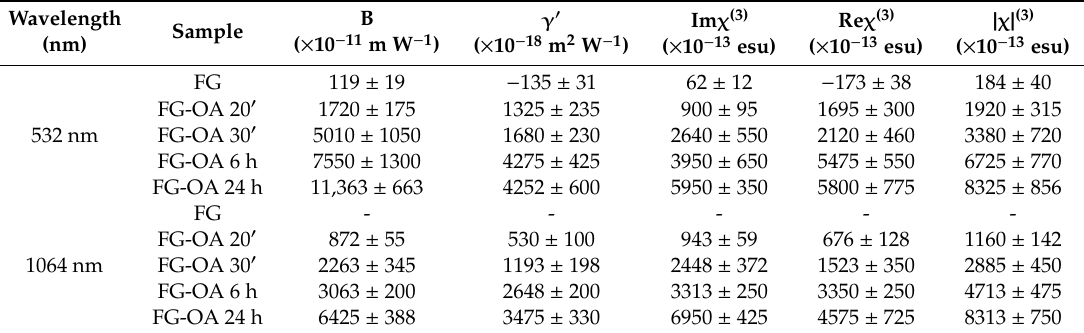
Table 1. NLO parameters of the di ff erent octylamine-functionalized FGs.